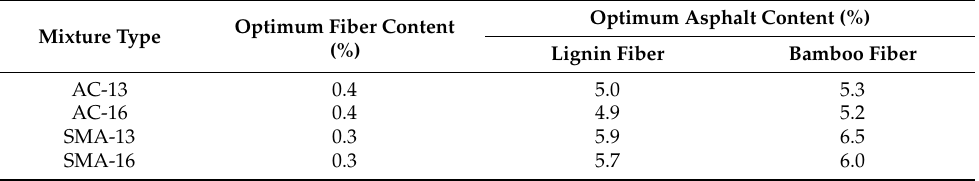
Table 6. Optimum fiber and asphalt content of each fiber asphalt